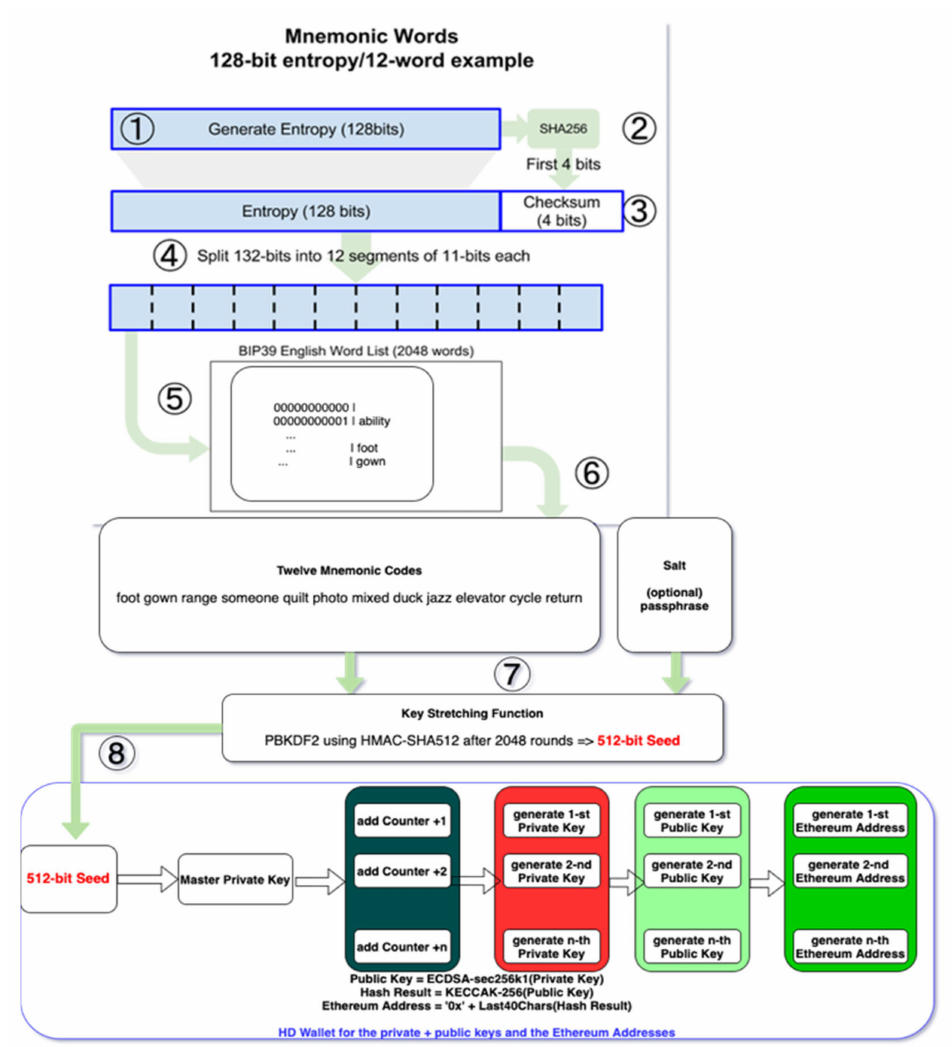
Figure 6. Ethereum Addresses generation from 12 words mnemonics BIP-39 “foot gown range someone guilt photo mixed duck jazz elevator cycle return” and obtaining the Ethereum Addresses within a HD